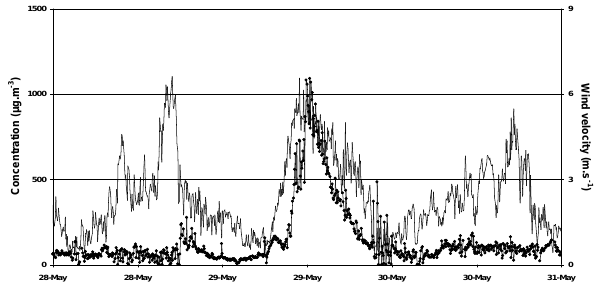
Fig. 12. 5-min PM 10 concentrations (black dots) and surface wind velocities (black line) measured in M’Bour from 28 to 31 May